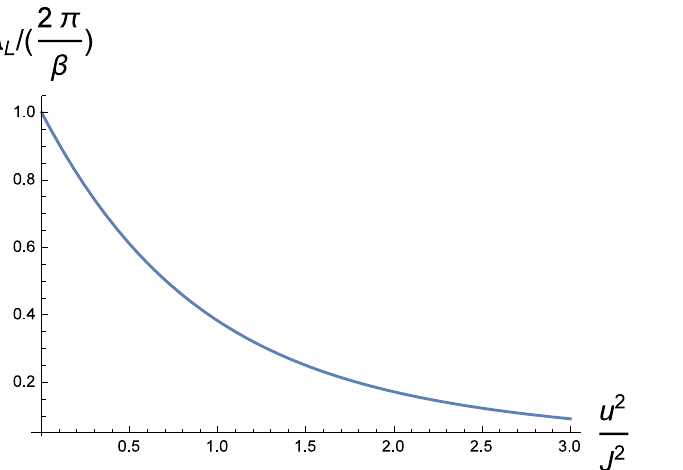
Figure 3 . The dependence of Lyapunov exponent of F (cid:31)(cid:31) on u 2 =J 2